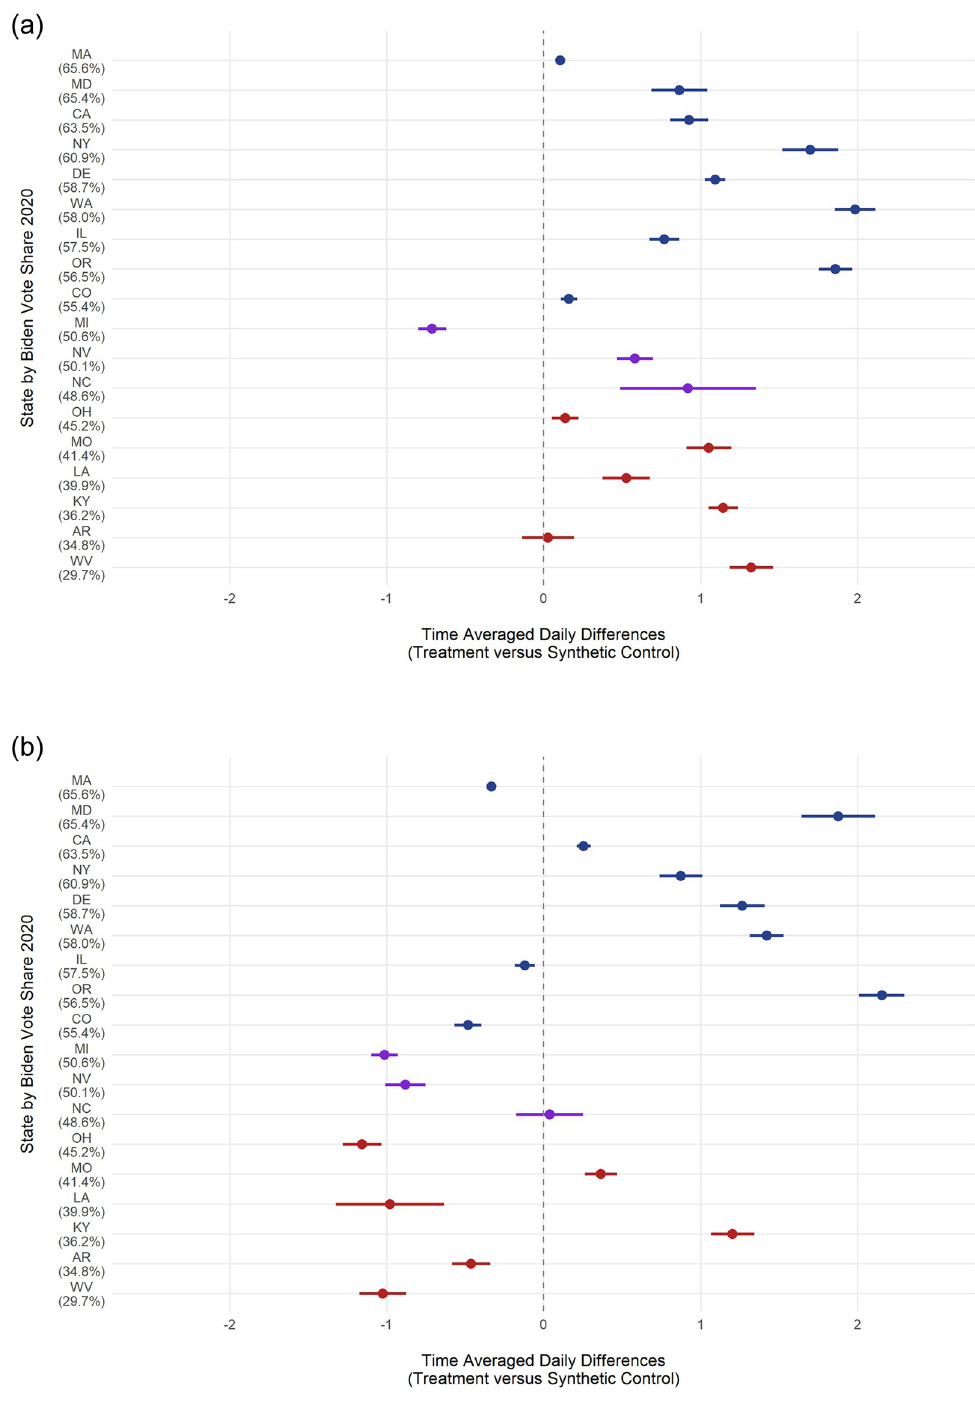
Fig 3. TADD estimated effects of lotteries on vaccination rates by state and 2020 Biden vote-share. A: First-Dose B: Complete.